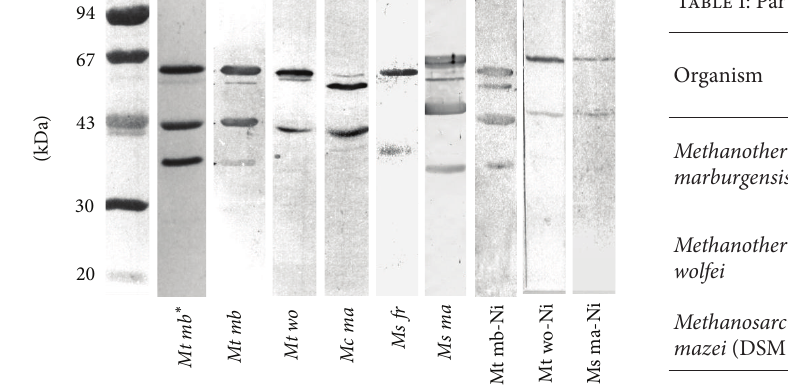
Table 1: Partitioning of MCR as revealed by